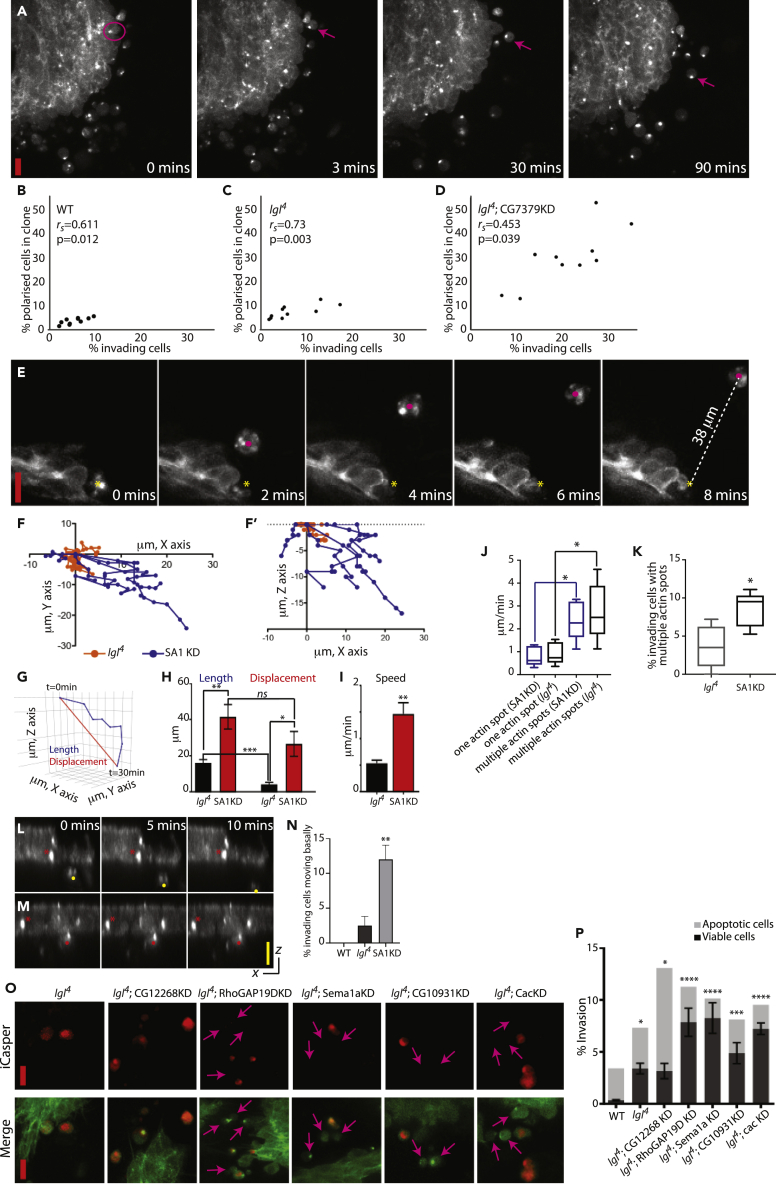
Characterization of Selected Invasion Suppressors(A) An example of a highly invasive mutant clone (genotype: lgl4; CG7379KD) labeled with GFP:Moe. Highlighted is a pre-invasive cell that rounds up and forms a characteristic actin-rich spot at one side of the cell before invasion (0 min). The cell then detaches from the mutant clone and migrates away (arrow).(B–D) Correlation between the percentage of clonal cells with a polarized actin accumulation and the percentage of invading cells per animal (n = 10 animals/genotype). (B) WT, (C) lgl4, (D) lgl4; CG7379KD. The two parameters show a significant correlation, irrespective of whether the mutant clones were rarely invasive or highly invasive.(E–F') (E) Stills from a time-lapse showing the basal surface of a GFP:Moe-labeled SA1KD clone. Yellow star marks the initial location of an invading cell; magenta dot shows the location of the invading cell at the indicated time. The cell shown has moved 38 μm in 8 min. (F and F′) Representative single-cell trajectories from lgl4 (orange) and SA1KD invading cells (blue) shown in xy (F) and xz (F′). Each cell was measured every 3 min for 30 min.(G) Illustration showing the two trajectories measured for each invading cell to determine directionality. Length (blue) follows the full trajectory of an invading cell. Displacement (red) measures a straight line from the initial to the final point.(H) Quantification of length and displacement from lgl4 and SA1KD cells (n = 25 cells from 5 animals/genotype). Cells that have directionality have no significant difference between length and displacement.(I) Quantification of speed of migration, showing average micrometers traveled per minute (n = 25 cells from 5 animals/genotype).(J) Quantification of speed of migration (μm/minute) for lgl4 and SA1KD cells that present either a single actin spot or multiple actin spots (n = 5 cells/group). Those with multiple spots travel faster irrespective of genotype.(K) SA1KD cells have a significantly higher proportion of invading cells with multiple actin spots (n = 5 animals/genotype).(L and M) Orthogonal view of invading cells showing that cells only migrate once detached from the epithelial sheet (yellow dot, (L)). Red asterisk, pre-invasive cell within sheet; red dot, delaminated cell still attached to sheet (M).(N) Quantification of the percentage of pre-invasive cells that detach from the epithelial sheet and migrate, in WT, lgl4, and SA1KD clones (n = 3 animals/genotype).(O) iCasper (red) and GFP:Moe (green)-labeled mutant clones (genotypes specified above panels). Arrows highlight invading cells that are iCasper negative. (P) Four of the five invasive genotypes tested showed a high proportion of invading cells that were iCasper negative (n = 10 animals/genotype). Error bars = ± SEM. Student's t test or one-way ANOVA with Dunnett's post hoc test for multiple comparisons was performed to determine statistical significance. p > 0.05 was considered not significant, ∗p < 0.05, ∗∗p < 0.01, ∗∗∗p < 0.001, ∗∗∗∗p < 0.0001. Red scale bar, 10 μm; yellow scale bar, 10 μm in the xz plane.See also Figure S4.